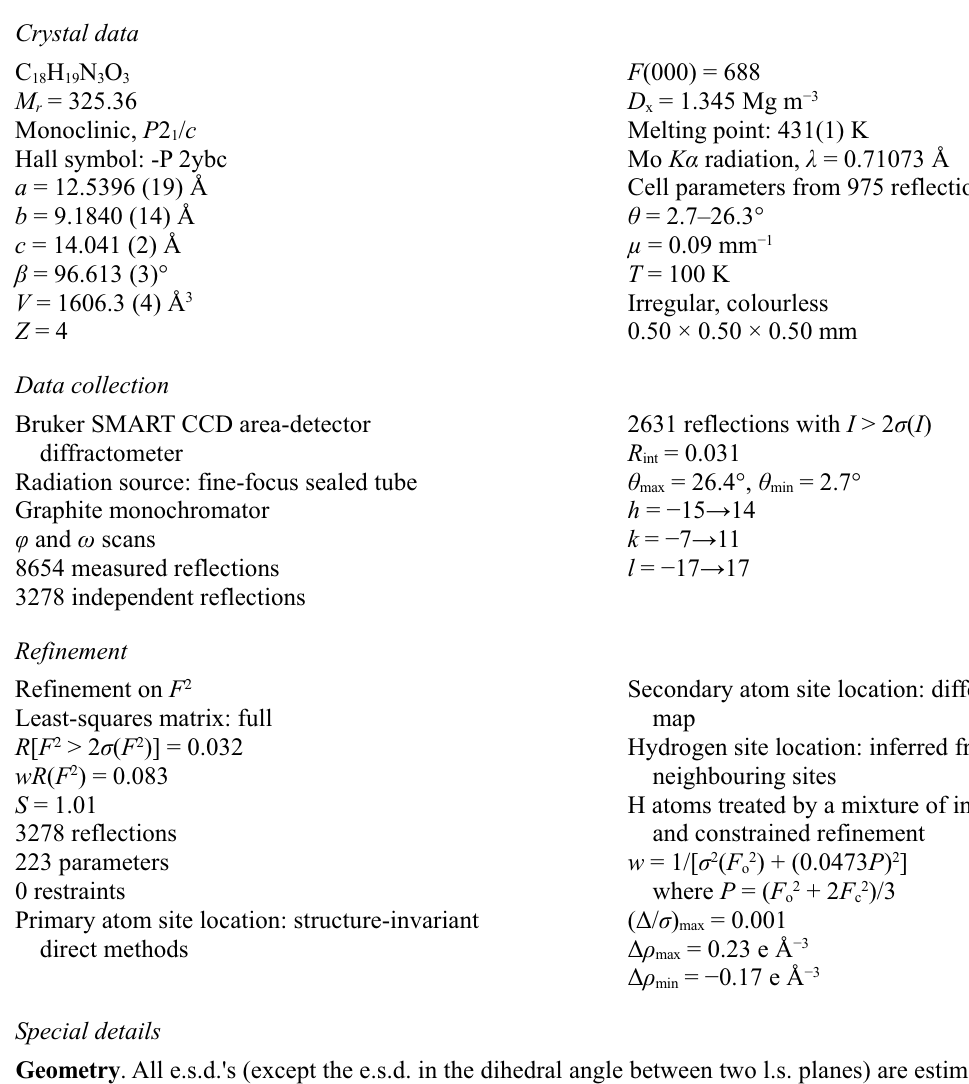
Figure 2 Crystal packing of the title compound viewed along the b axis. Hydrogen bonds are shown as dotted